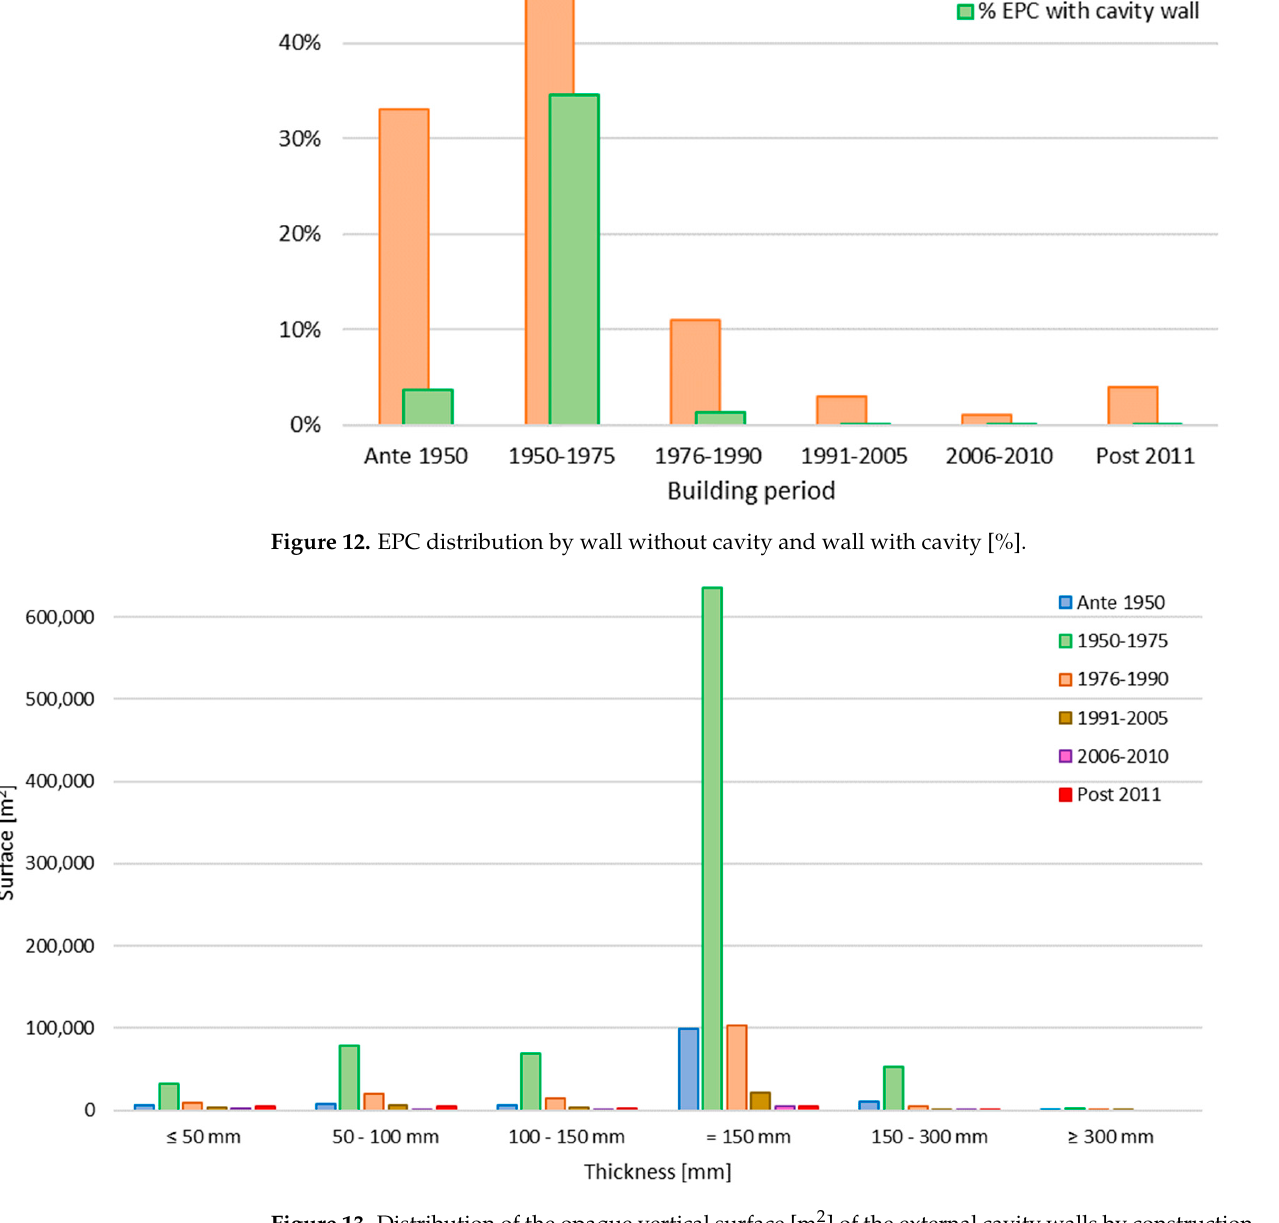
Figure 13. Distribution of the opaque vertical surface [m 2 ] of the external cavity walls by construction period and thickness ranges